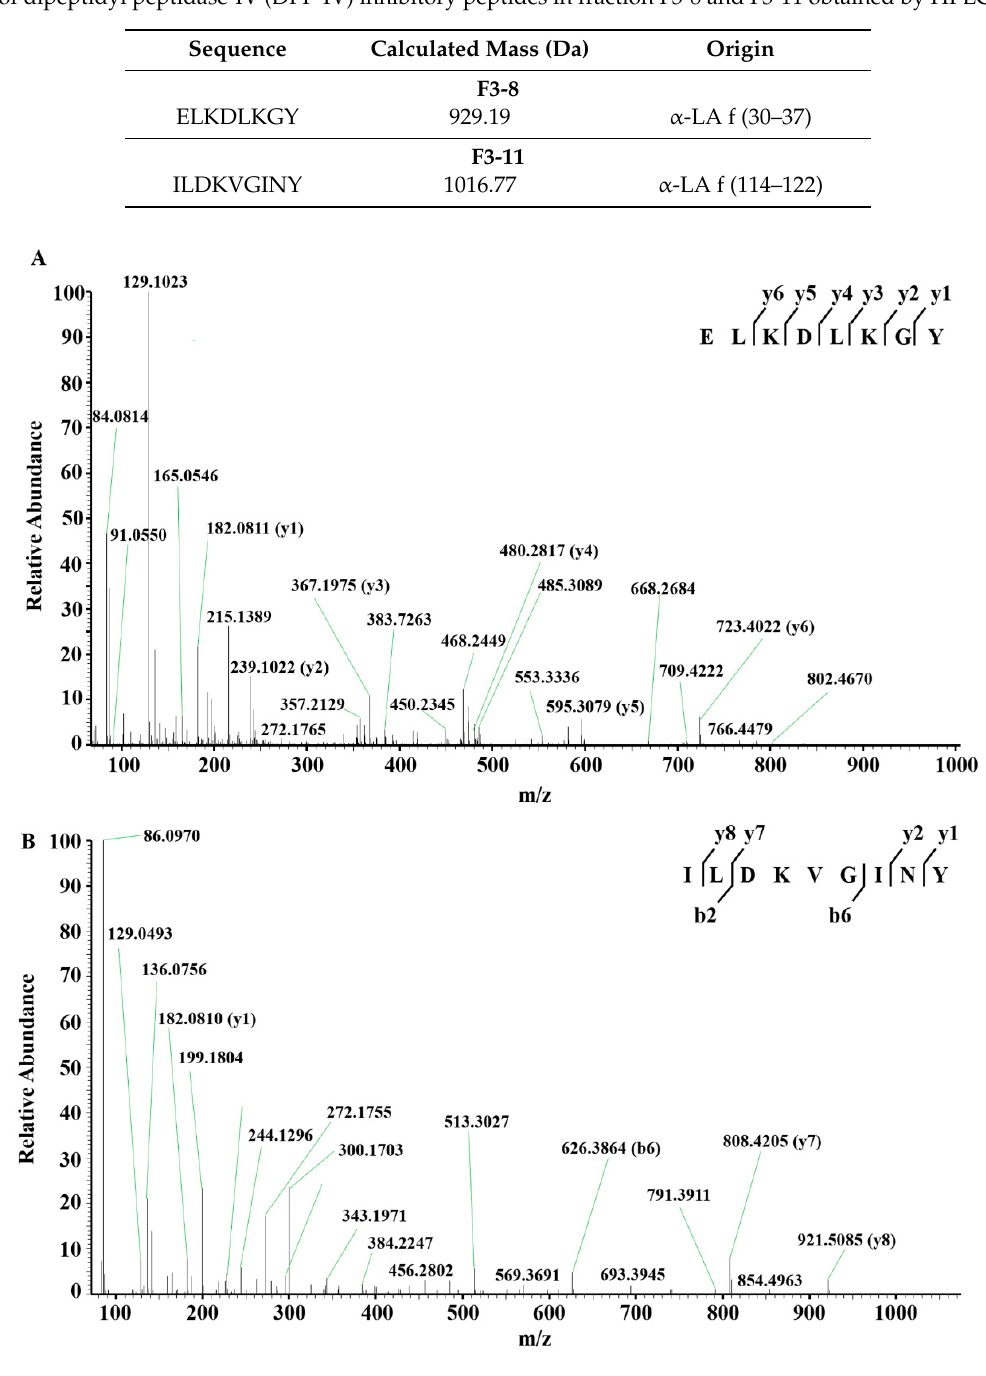
Figure 4. Identification of DPP-IV inhibitory peptides. ( A ) LC-MS / MS spectrum of single-charged ion with m / z 483.26996. Following sequence interpretation and database searching, the MS / MS spectrum of ion with m / z 483.26996 was matched to peptide ELKDLKGY. ( B ) LC-MS / MS spectrum of single-charged ion with m / z 517.79901. Following sequence interpretation and database searching, the MS / MS spectrum of ion with m / z 517.79901 was matched to peptide ILDKVGINY. Peptide sequences are displayed with ion fragments observed in the spectrum.